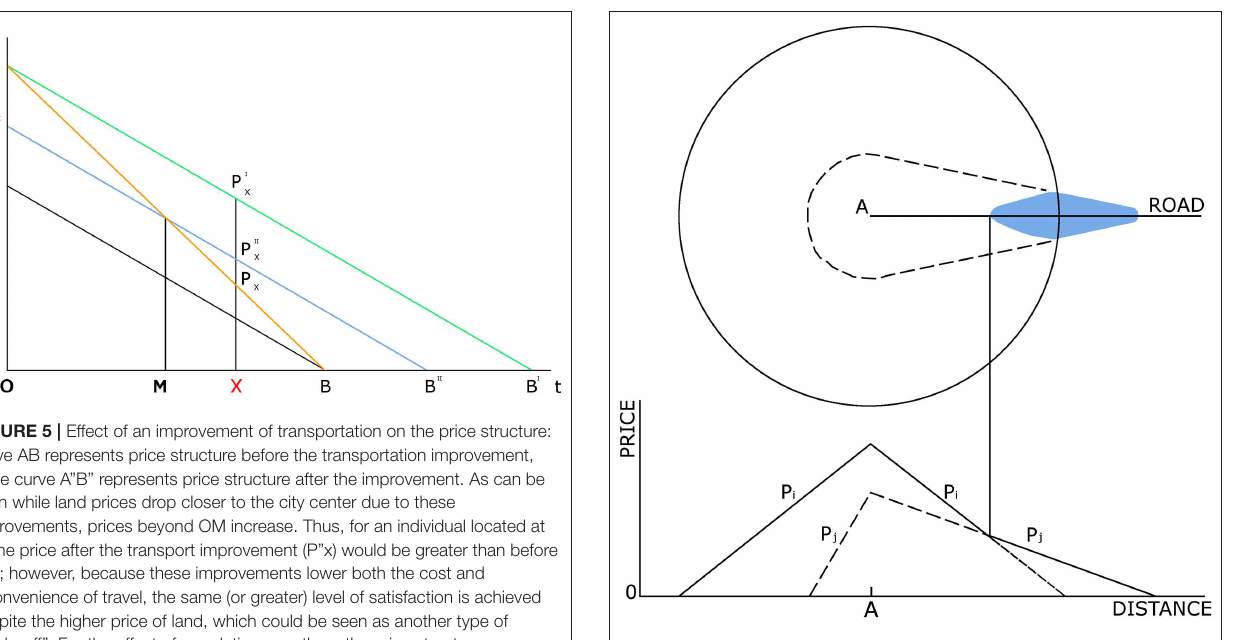
FIGURE 6 | Rent and occupancy patterns for a city with a center and a high-status road. NB: extension of bid-rent surface beyond previous settlement “margins” ( Alonso, 1964, p. 141, fig. 43 in Location and Land Use: Toward a General Theory of Land Rent Cambridge, Mass.: Harvard University Press, Copyright © 1964 by the President and Fellows of Harvard College. Reproduced with